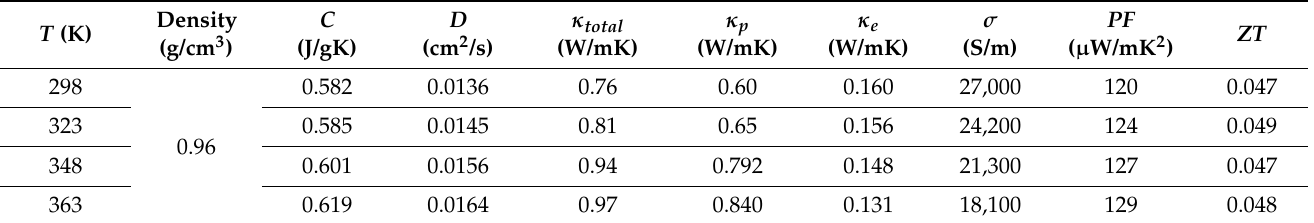
Table 1. The in-plane total thermal conductivity, κ total , phonon thermal conductivity, κ p , electronic thermal conductivity, κ e , and figure of merit, ZT of the TiS 2 /organic superlattice film as a function of temperature within the range 298–363 K. The values of the density; specific heat capacity, C ; thermal diffusivity, D ; electrical conductivity, σ ; and power factor, PF of the TOS film are also shown in this temperature range.